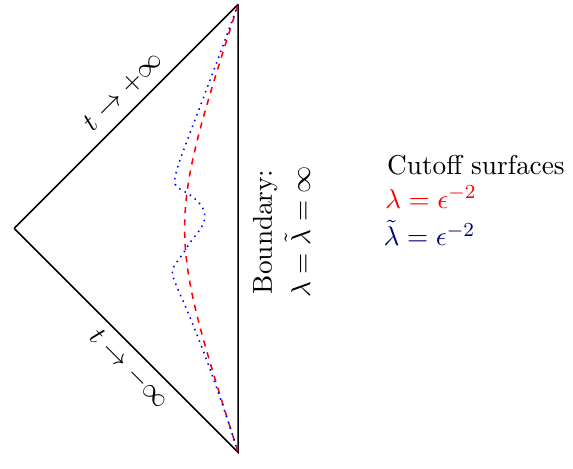
Figure 1 . A conformal diagram of the Poincar(cid:19)e-patch of AdS 3 . The vertical line is the asymptotic boundary while the two diagonal lines are the two Poincar(cid:19)e-horizons where t ! (cid:6)1 . The two cuto(cid:11) surfaces (cid:21) = 1 =(cid:15) 2 and ~ (cid:21) = 1 =(cid:15) 2 are shown as dashed (red) and dotted (blue) lines,